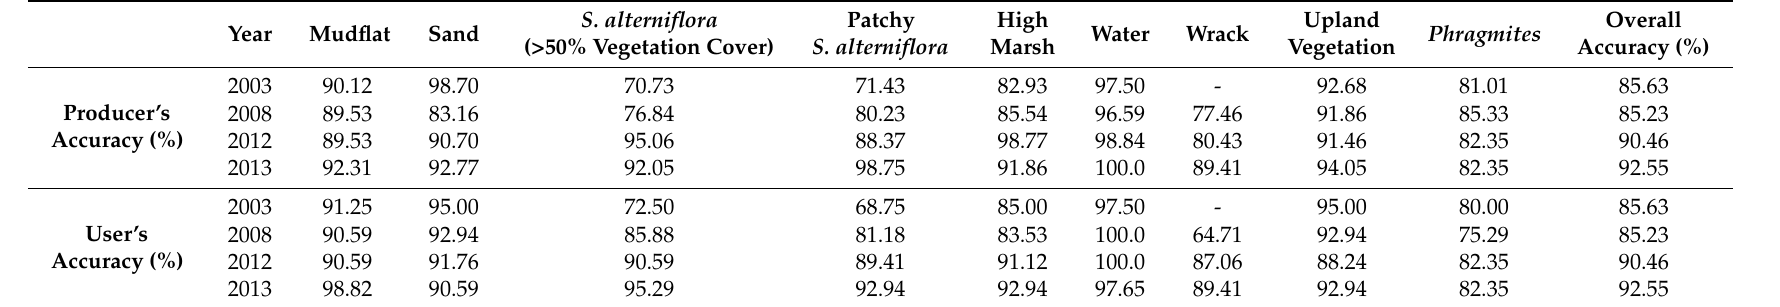
Table 2. Accuracy assessment analysis (producer’s, user’s, and overall accuracy).